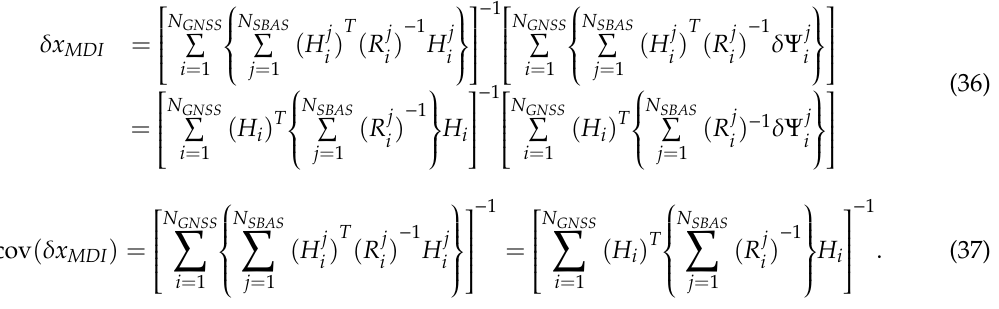
Figure 6. MDI for multi-GNSS augmented with multi-SBAS.